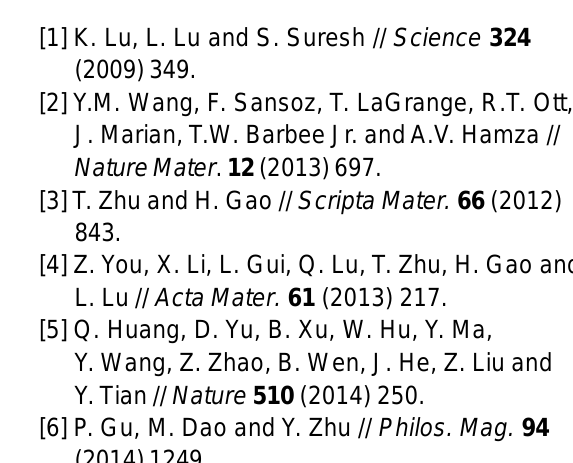
in the case eq eq ,  eq c2